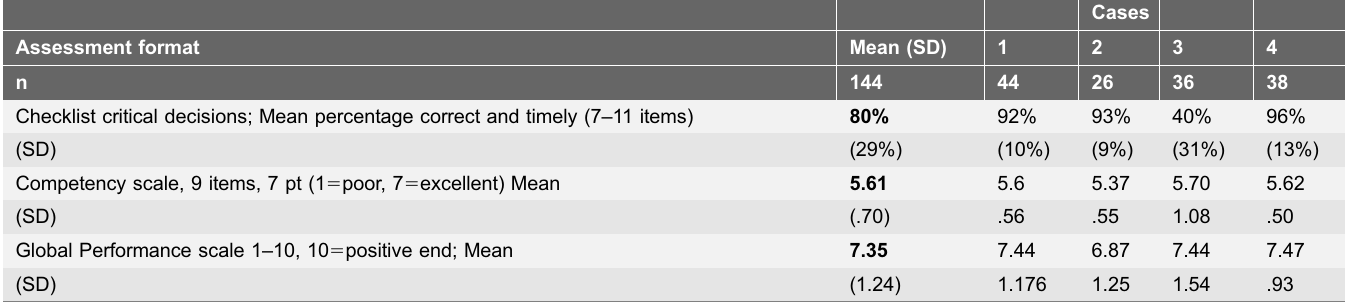
Table 1. Overview assessment results of the 3 parts of the skill assessment instrument (all cases).